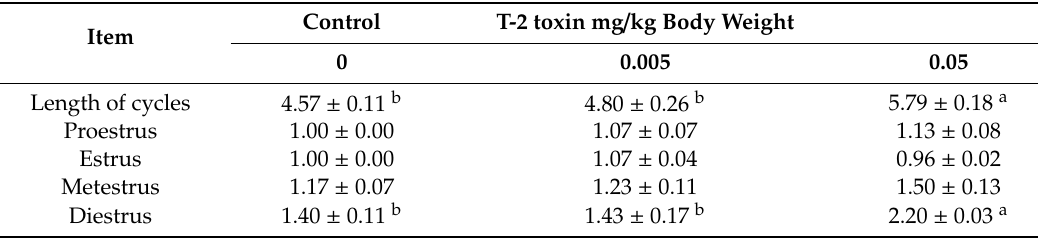
Table 2. The average length of the estrus cycle, stages of female mice whose dams were orally administered with T-2 toxin at 0, 0.005, and 0.05 mg / kg from gestational day 14 (GD 14) to lactational day 21 (LD 21).